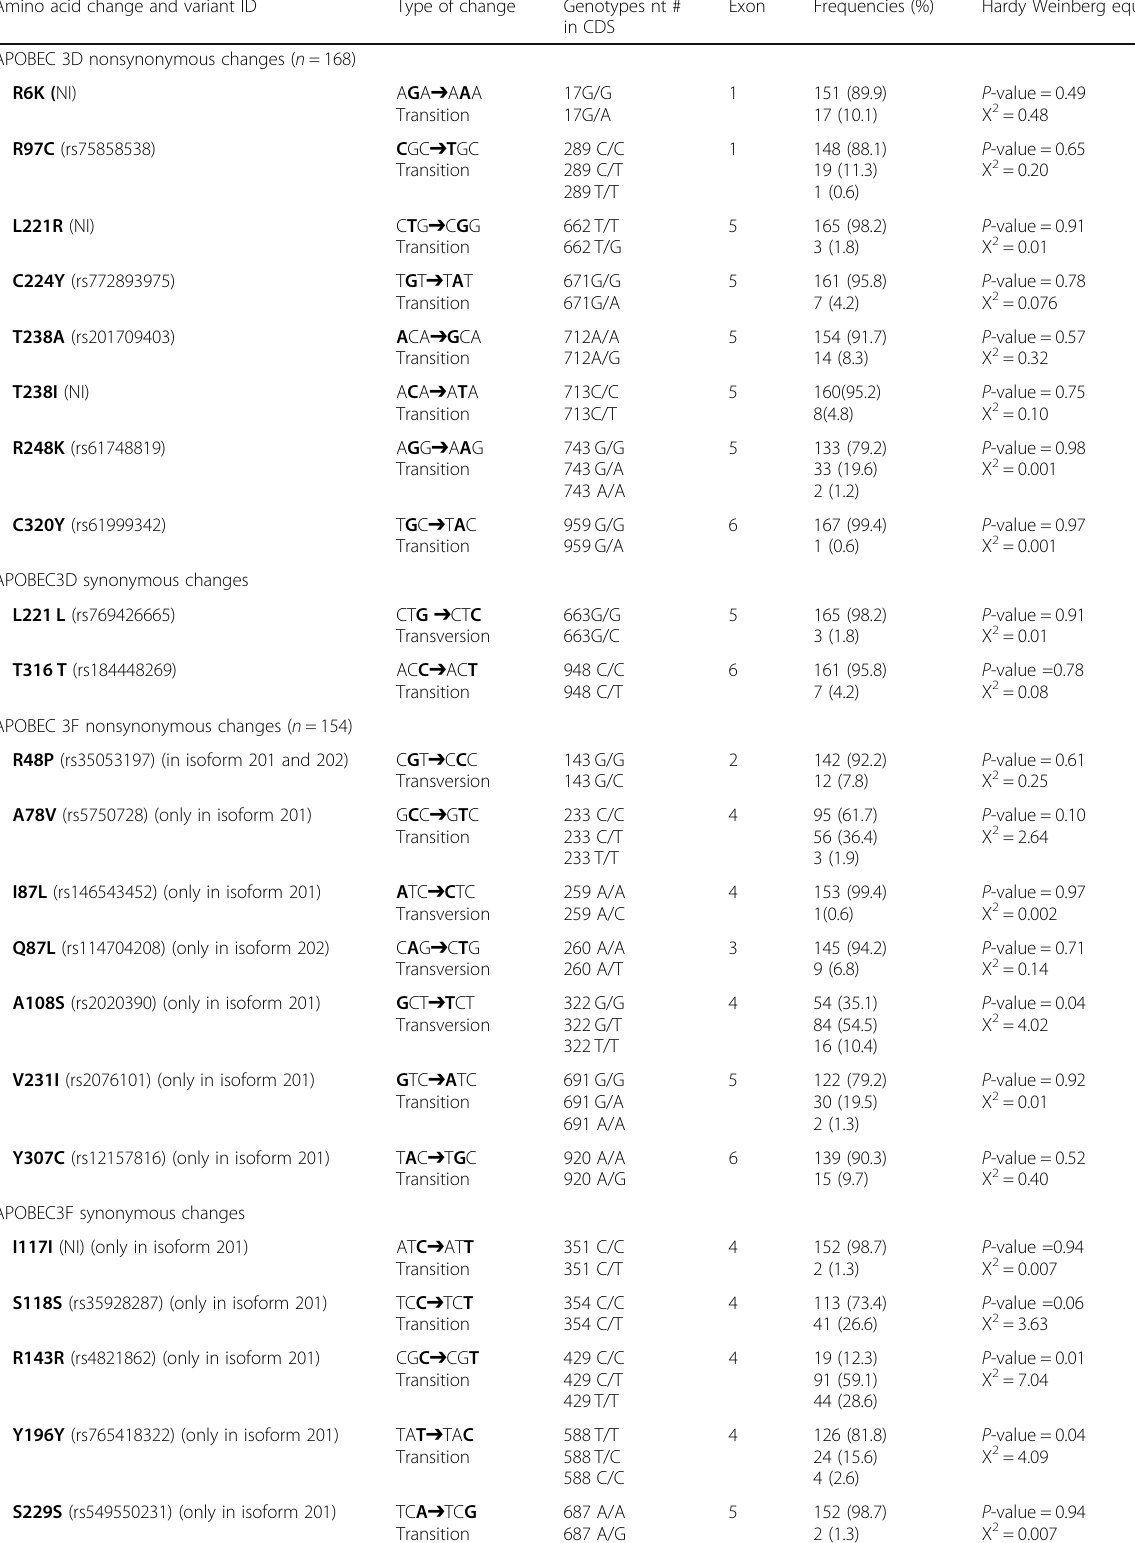
Table 2 APOBEC 3D, 3F, 3G and 3H nonsynonymous and synonymous changes, genotypes, amino acid position and change in the protein, frequencies and Hardy Weinberg Equilibrium calculations from the study